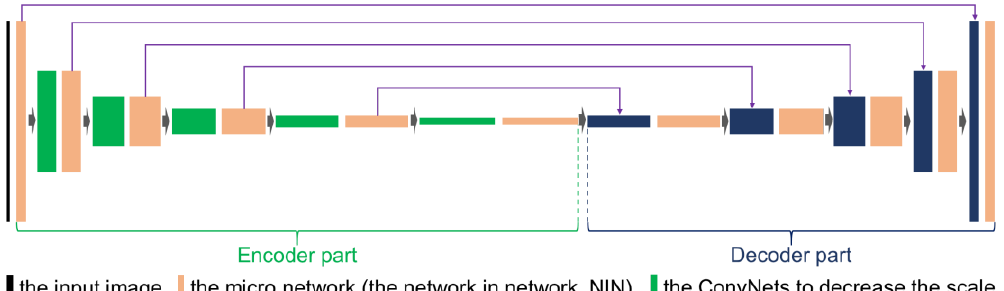
Figure 4. The proposed sky and ground segmentation network. The green and blue braces refer to the encoder and decoder